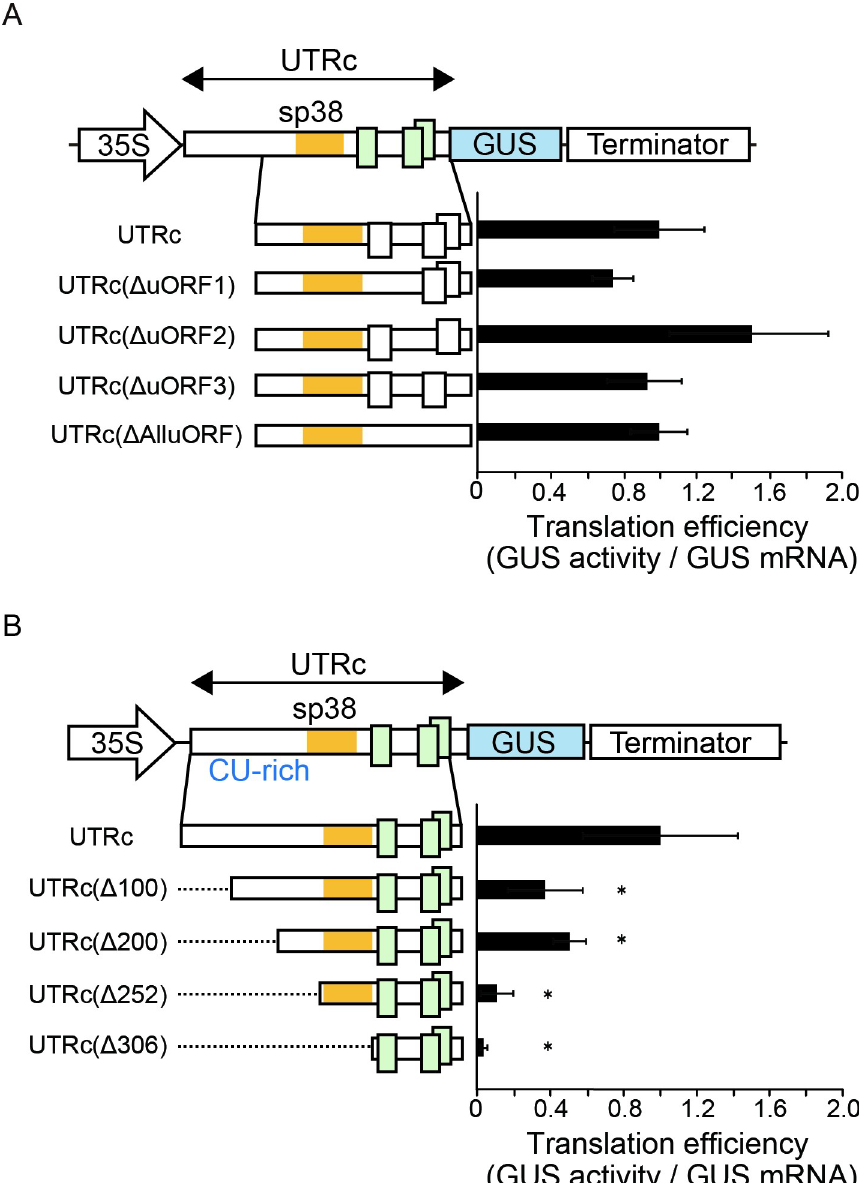
Fig 4. Identification of regulatory UTRc cis -elements involved in the modulation of OsMac1 mRNA translation. (A) Mutations introduced in the UTRc leader to exclude uORF1, uORF2, uORF3 or all the AUG codons (AUG codon was replaced by UUG). UTRc-, UTRc ( Δ uORF1)-, UTRc ( Δ uORF2)-, UTRc ( Δ uORF3)-, and UTRc ( Δ AlluORF)- containing reporters were used for transformations. (B) Translational efficiency of truncated UTRc mutants. UTRc ( Δ 100), UTRc ( Δ 200), UTRc ( Δ 252), and UTRc ( Δ 306) are truncated UTRc mutants in which regions of 100 nt, 200 nt, 252 nt and 306 nt were deleted from the 5’ end, respectively, as shown by broken lines. sp38 and uORFs are shown as orange-colored boxes and enlarged open boxes, respectively. Translational efficiencies are shown as the relative GUS activities that are normalized by the amount of mRNA. The value of the GUS activity of UTRc is set as 1.0. The results represent the means of three independent experiments. Error bars indicate the SD (n = 3). Asterisks indicate significant differences in the translational efficiency of UTRc at P < 0.05.